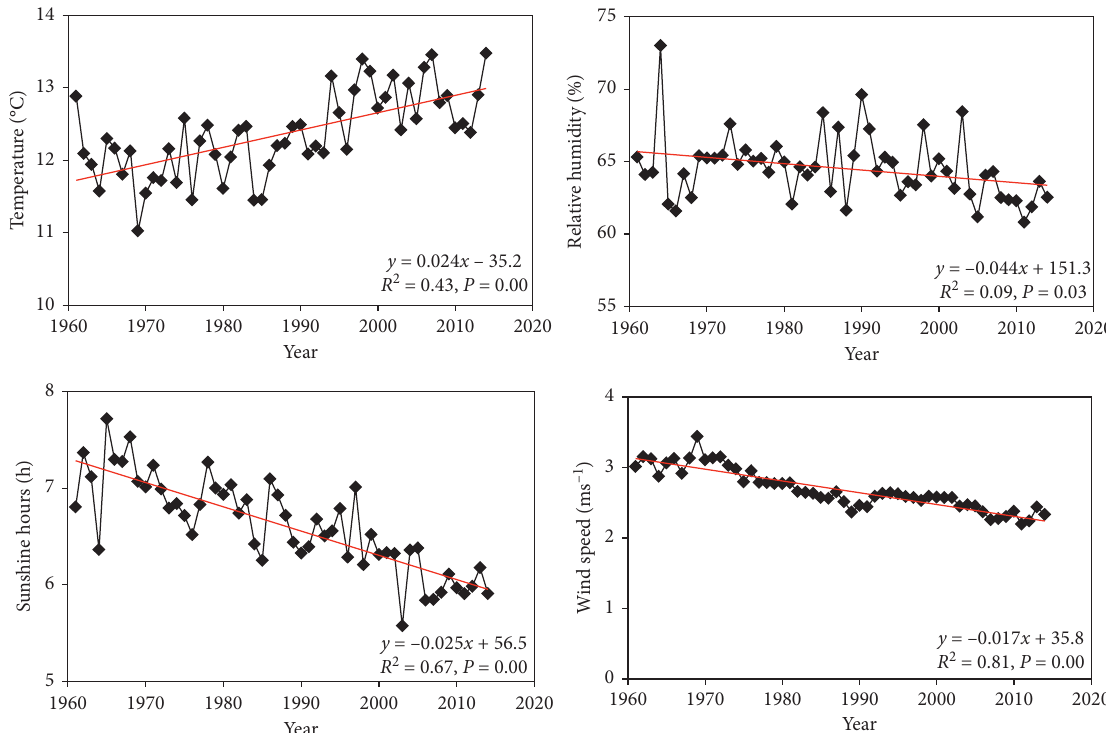
Figure 6: Tendency rate of temperature (a), relative humidity (b), sunshine hours (c), and wind speed (d) from 1961 to 2014 in the